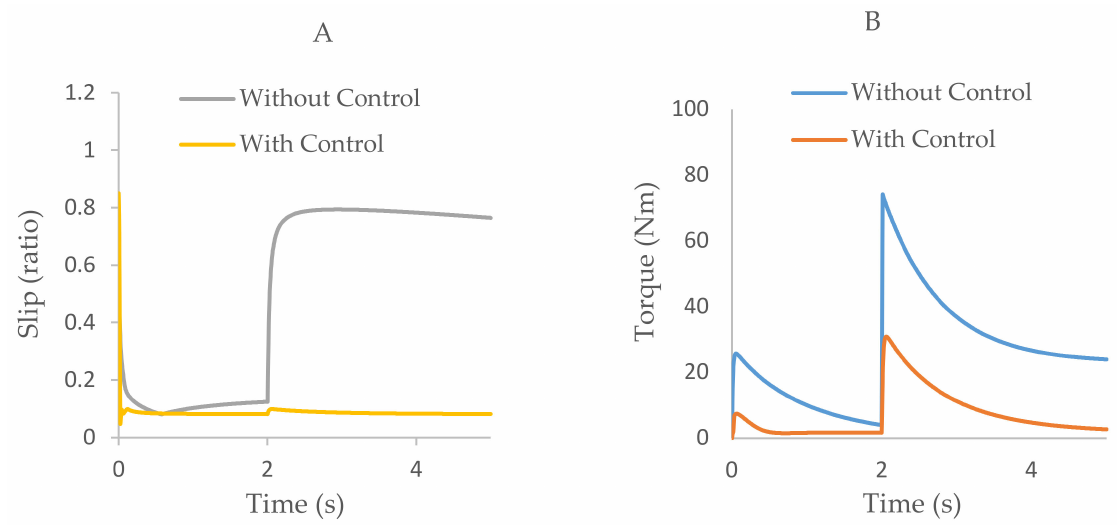
Figure 9. Controller performance in low µ terrain: ( A ) slip variation and ( B ) torque